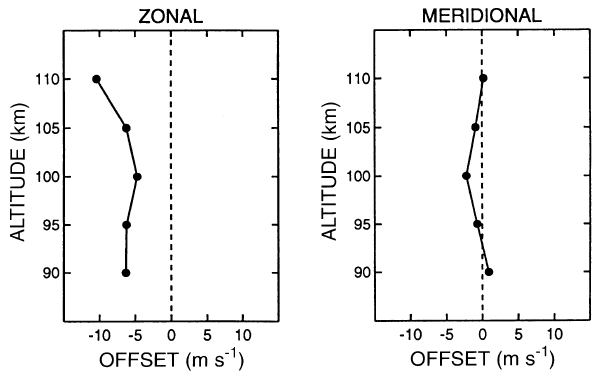
Fig. 10. Mean WINDII-HRDI o(cid:128)sets as a function of altitude for the zonal ( left-hand panel ) and meridional wind component ( right- hand panel )